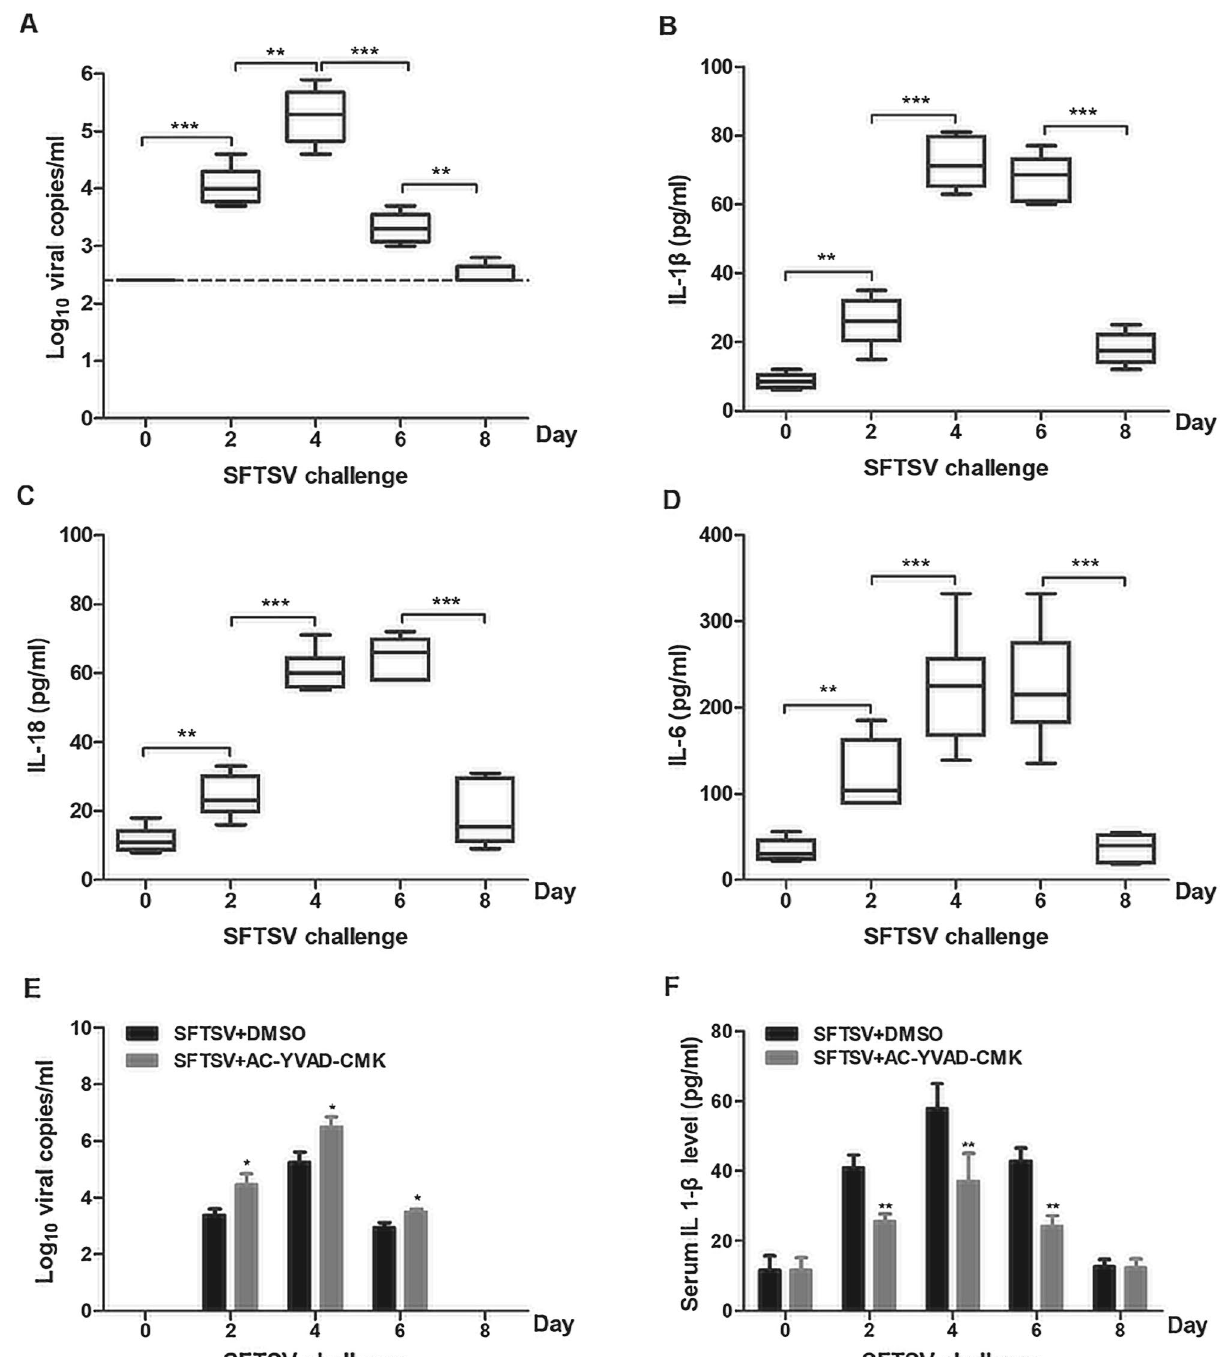
Figure 3. Caspase-1 dependent increase of IL-1β and IL-18 secretion in mice infected with SFTSV. Five-week- old C57BL/6 mice (male) were infected with SFTSV (1 × 10 5 PFU) and measurement of IL-1β secretion and viral load in mouse sera was carried out at day 0, 2, 4, 6 and 8 p.i. Viral RNA copy numbers in the blood were determined by extraction of total RNA from the whole blood and RT-PCR with specific primers for the viral S genomic segment, while serum IL-1β levels by ELISA. ( A ) Viral RNA copy numbers and ( B ) IL-1β levels in the sera of the mice infected with SFTSV. C57BL/6 WT mice (5 weeks old, male) were pretreated with DMSO or Ac-YVAD-cmk (8 mg/kg) by intraperitoneal injection and then infected with SFTSV (1 × 10 5 PFU) or with PBS. At each time point, on day 0, 2, 4, 6, and 8 days p.i., six mice from the Ac-YVAD-cmk or control group were sacrificed, and viral RNA copy numbers in the blood were determined by RT-PCR (C) . The levels of IL-1β, IL-18 and IL-6 in mouse sera were determined by ELISA ( D – F ). Data shown were whiskers: min.-max.; * P < 0.05, *** P < 0.01, *** P < 0.001 (one-way ANOVA with SNK post-hoc